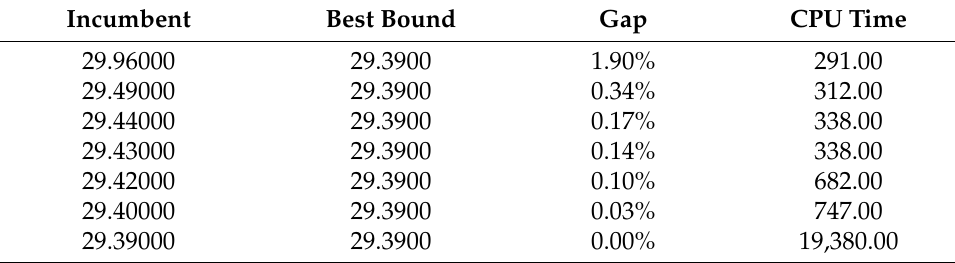
Table 5. Performance GUROBI solver—Biobio Instance.